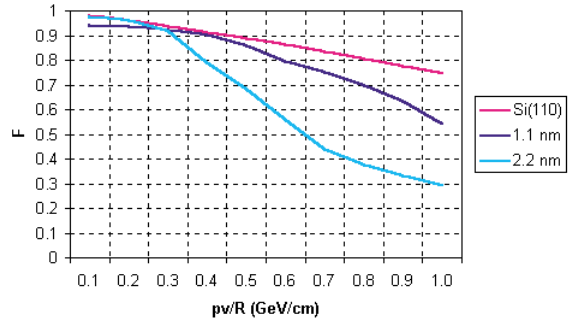
FIG. 2. (Color) The number of channeled protons as a function of the nanotube curvature p(cid:7)=R for tubes of different diame- ters (bottom up: 2.2 and 1.1 nm). For comparison, also shown is the same function for Si(110) crystal (top